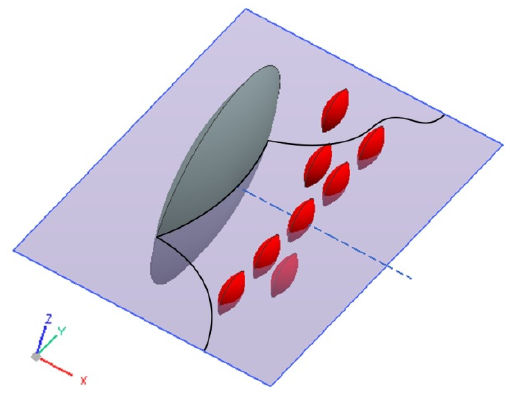
Figure 10. Three ‐ dimensional schematic, showing precipitates contributing to the back ‐ stress on the Figure 10. Three-dimensional schematic, showing precipitates contributing to the back-stress on dislocation. the